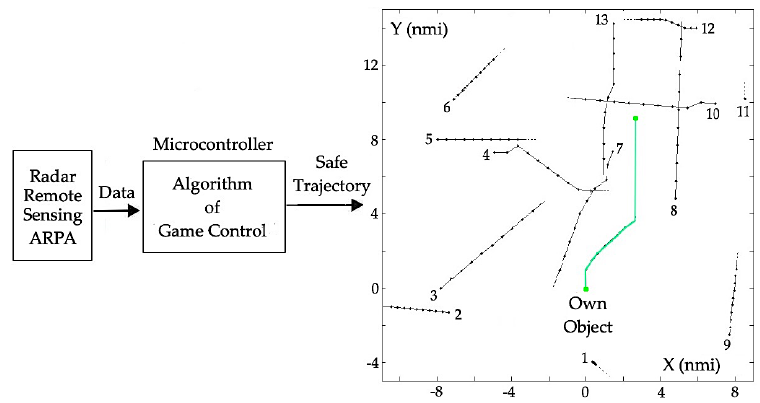
Figure 2. The system of computer-aided object safe control.